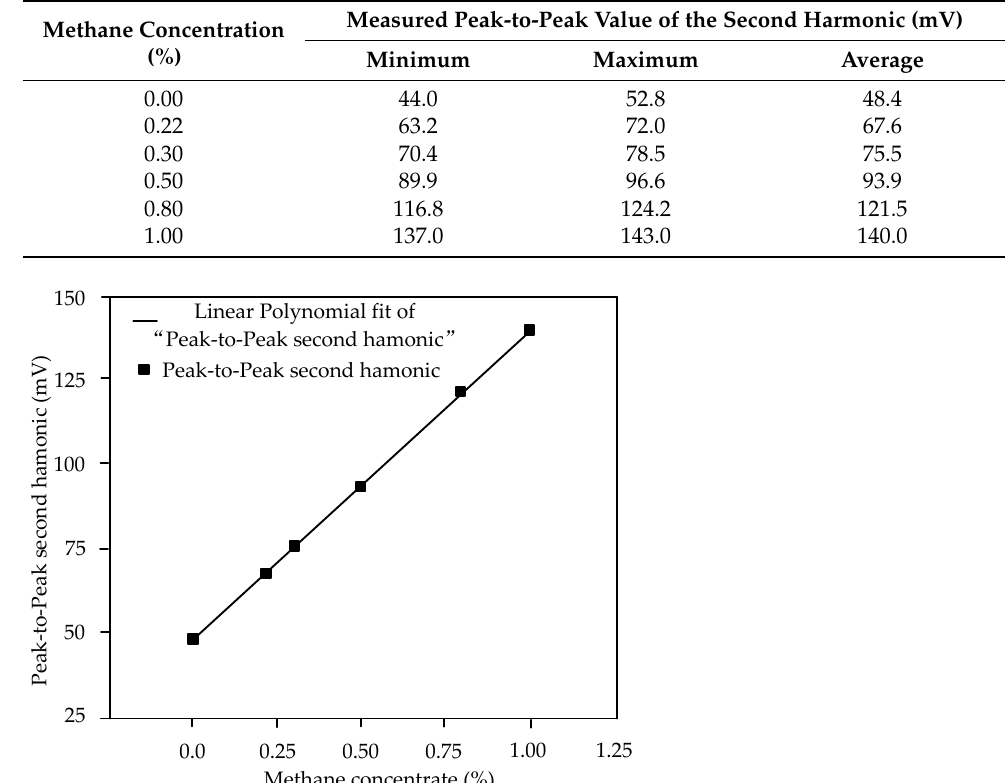
Table 2. Experimental results of the relationship between the second harmonic peak-to-peak value and the methane concentration.